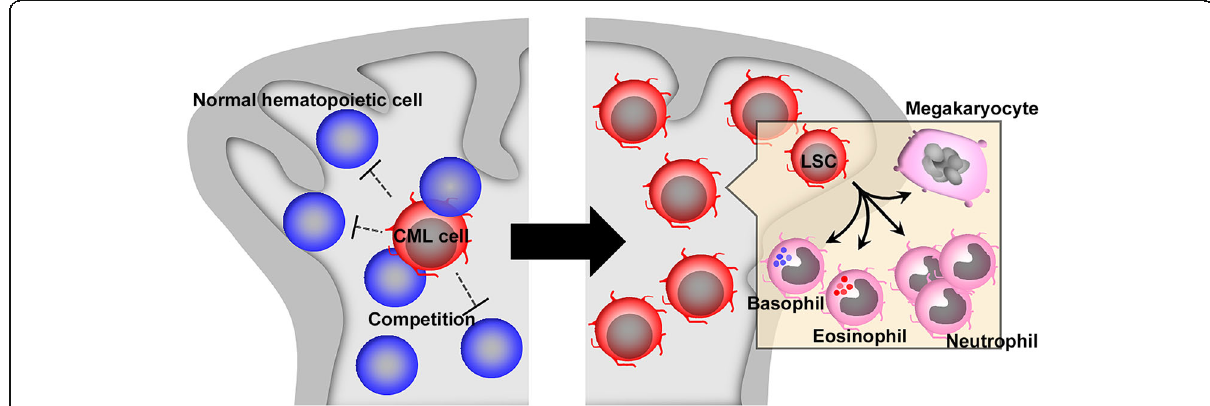
Fig. 4 CML progression. BCR-ABL gene transforms HSCs into LSCs, which gradually and clonally proliferate in competition with a large number of normal hematopoietic cells to eventually occupy bone marrow and migrate into other tissues including peripheral blood and spleen. CML LSCs simultaneously differentiate into more mature leukemia non-stem cells and as a consequence, CML cells consist of a small number of LSCs with the majority of leukemia non-stem cells including neutrophils, eosinophils, basophils and megakaryocytes. Moreover, these differentiated cells morphologically exhibit distinct features from LSCs but similar characteristics with normal